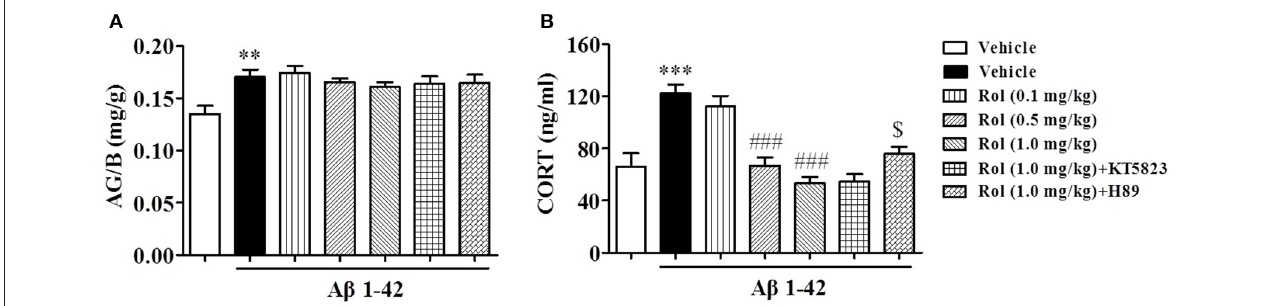
FIGURE 5 | The effects of rolipram on the ratio of adrenal gland weight to body weight (AG/B) (mg/g) (A) and serum corticosterone level (B) in A β 42-treated mice. Values shown are means ± SEM, n = 10; ** p < 0.01 and *** p < 0.001 vs. vehicle-treated control group. ### p < 0.001 vs. vehicle-treated A β group. $ p < 0.05 vs. rolipram (1.0mg/kg)-treated A β group.